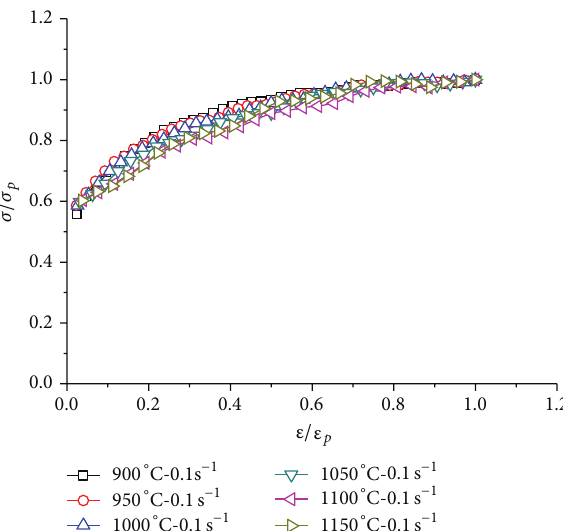
Figure 5: Relationship between 𝜎/𝜎 𝑝 and 𝜀/𝜀 𝑝 under different deformation conditions.